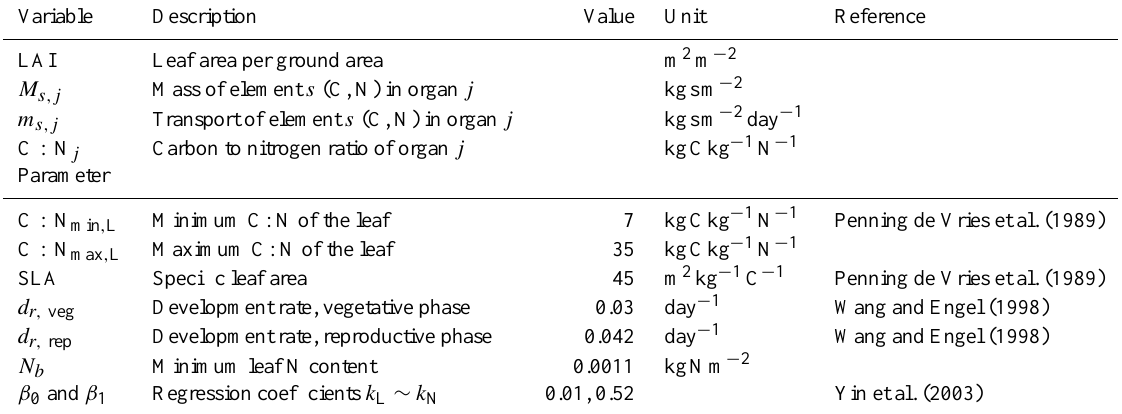
Table A2. A list of variables (in italics) and parameters used in the paper with a short description and units. Variable Description